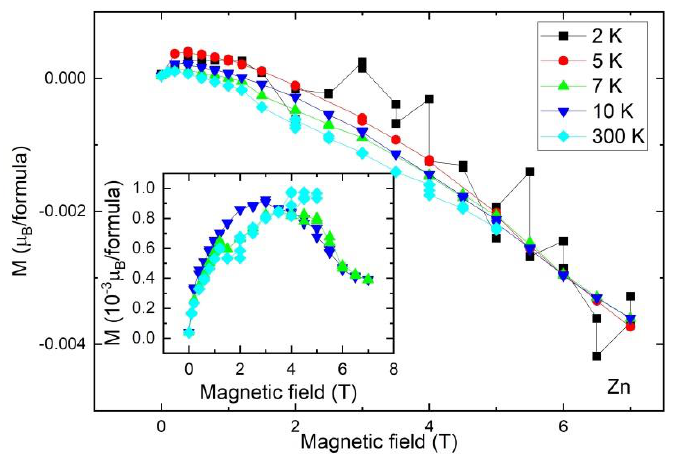
Figure 12. Magnetization of Zn(L)Cl 2 as the function of magnetic field at 2.0, 5.0, 7.0, 10.0, and 300.0 K after the extraction of an off-center linear diamagnetic background M / B ≈ − 0.085 µ B / formula T − 1 , associated with the sample holder. The insert shows the data for T = 7 K, 10 K, and 300 K after the subtraction of an additional diamagnetic background of − 0.04 µ B / formula T − 1 .